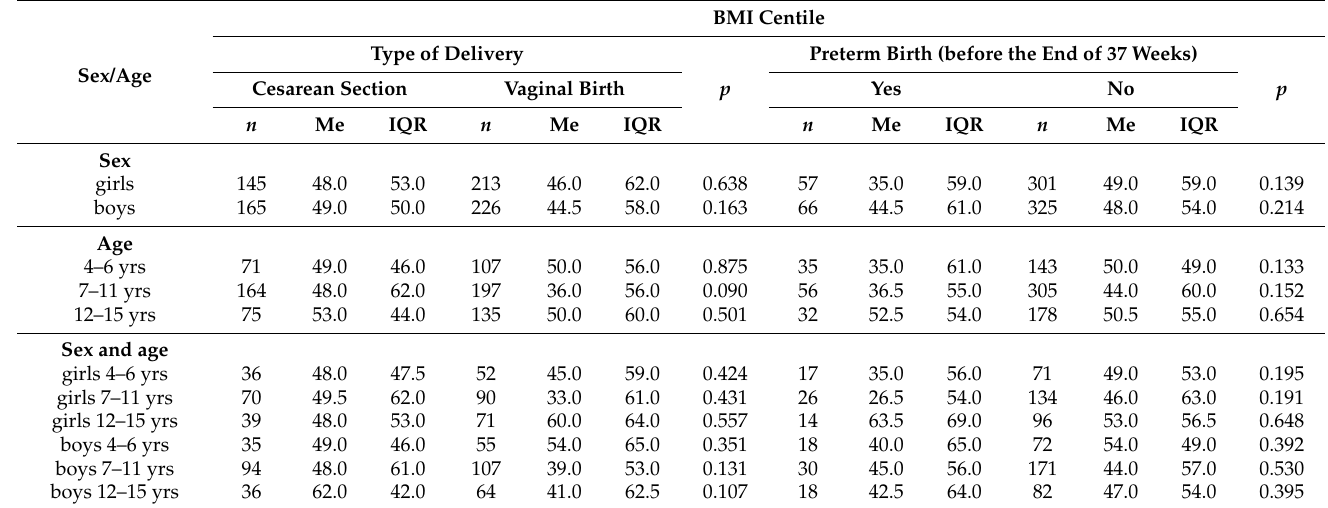
Table 2. BMI centile value depending on the type of delivery and preterm birth.